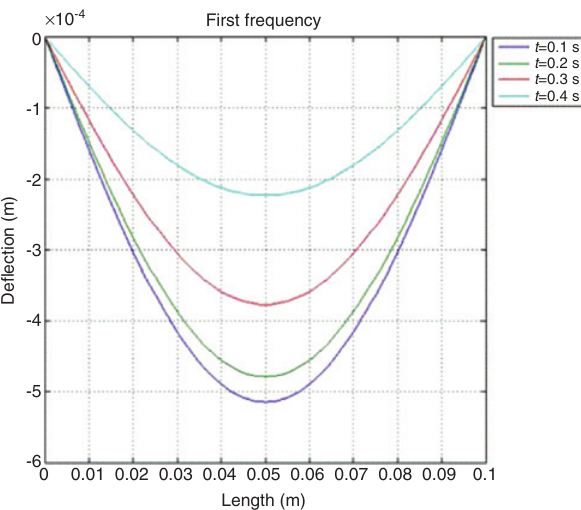
Figure 8: Vibrations of the third characteristic mode of the simply supported beam.